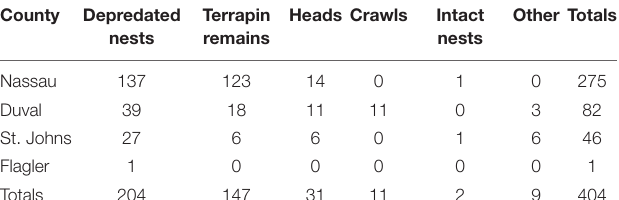
TABLE 1 | Records of Carolina Diamondback Terrapins in the four northeastern-most Florida counties of Nassau, Duval, St. Johns, and Flagler in 2013 and 2014.